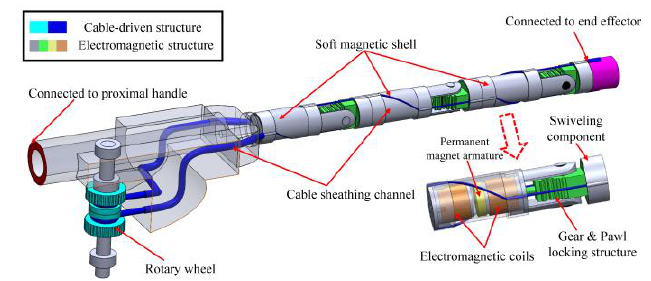
Figure 1. Design of the hybrid electromagnetic and tendon-driven